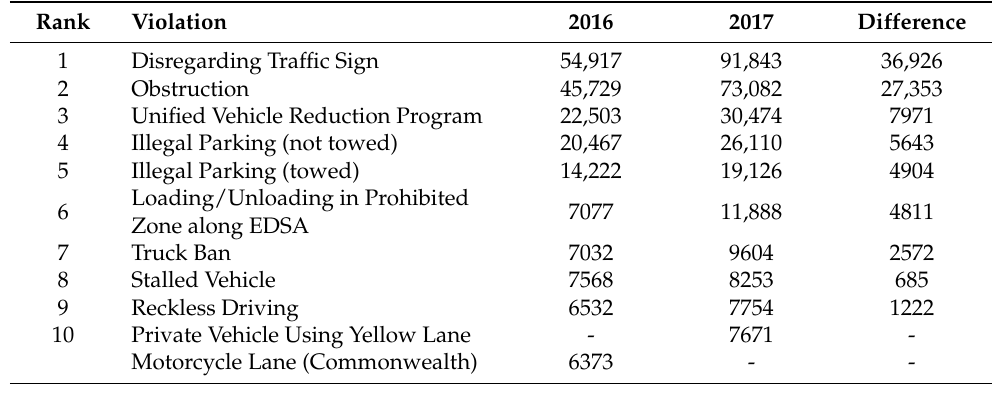
Table 1. Top 10 Traffic Violations in Metro Manila, 2016 and 2017.